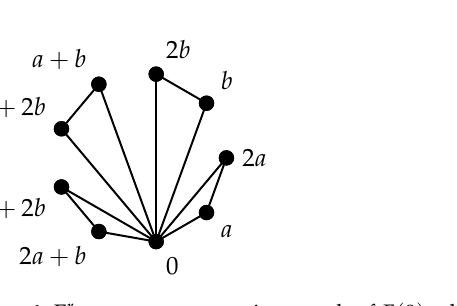
Figure 4. Γ r : r -noncommuting graph of E ( 9 ) when r = a + 2 b or 2 a + b E ( 9 )